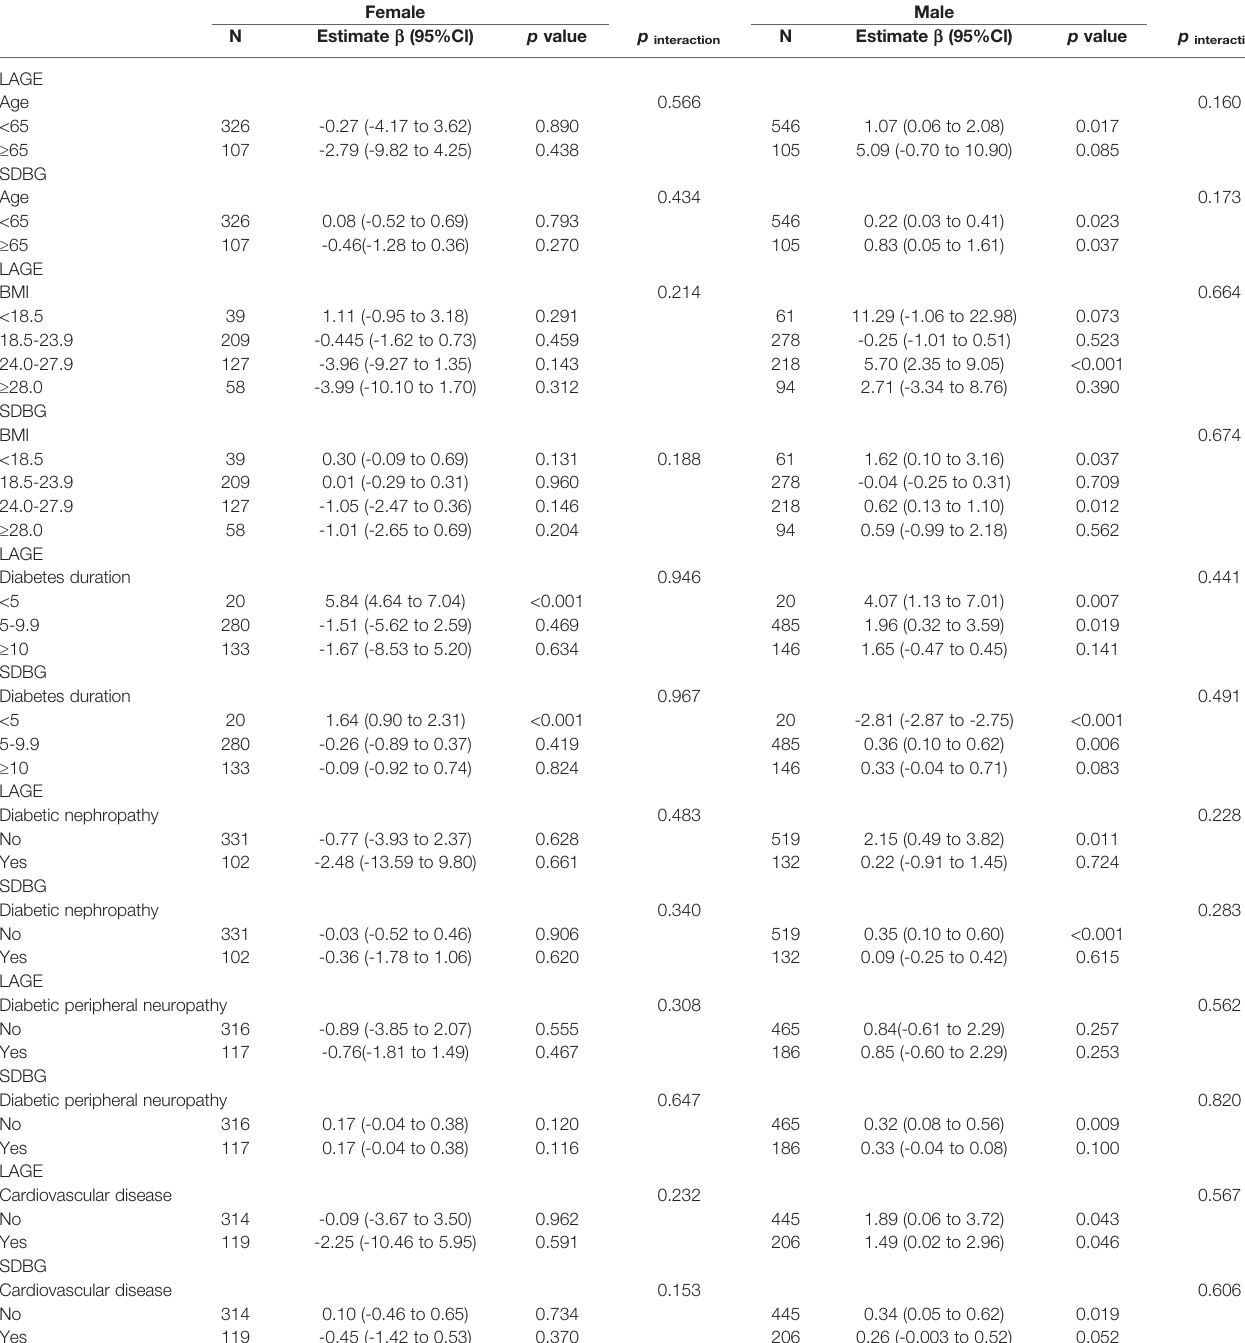
TABLE 3 | Subgroup analyses of associations of low muscle mass with glucose fl uctuations (LAGE and SDBG) among participants with type 2 diabetes receiving CSII